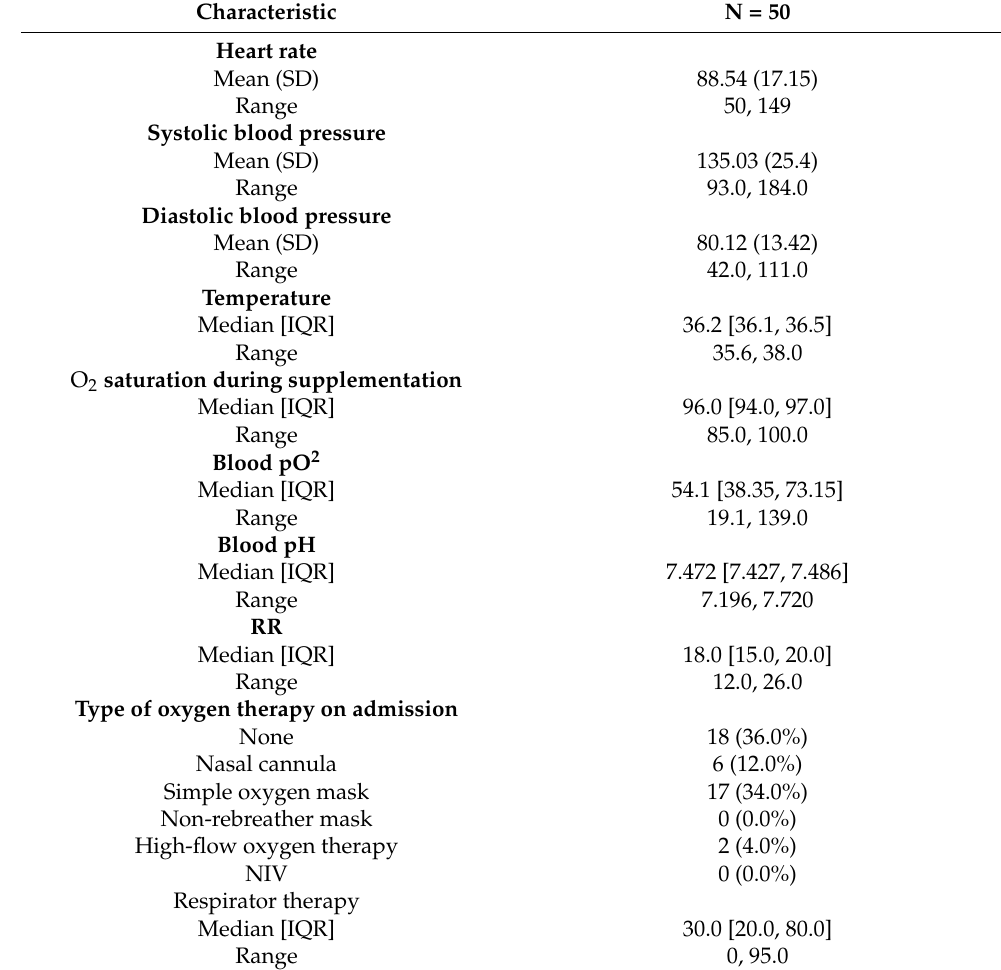
Table 4. Data on patient condition on